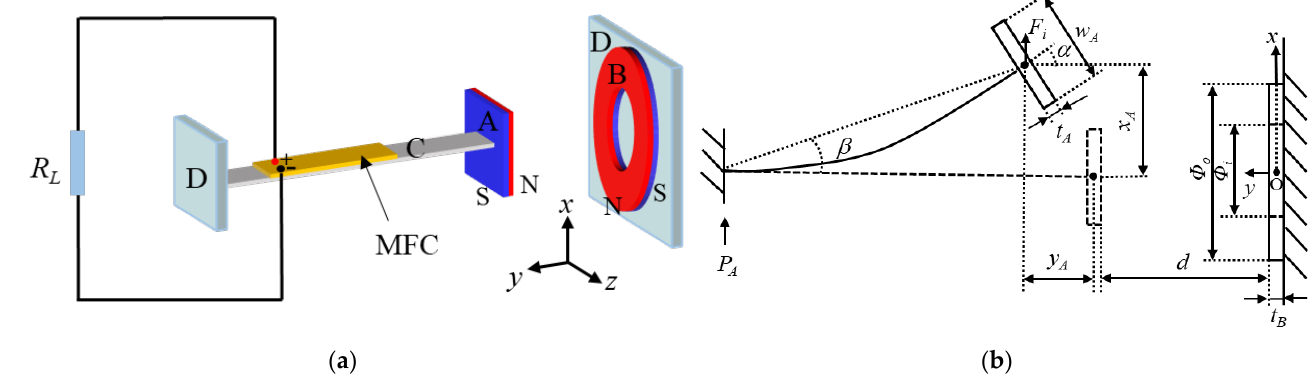
Figure 1. Schematics of the nonlinear QPEH with only one external magnet: ( a ) three-dimensional schematic; ( b ) two-dimensional schematic.